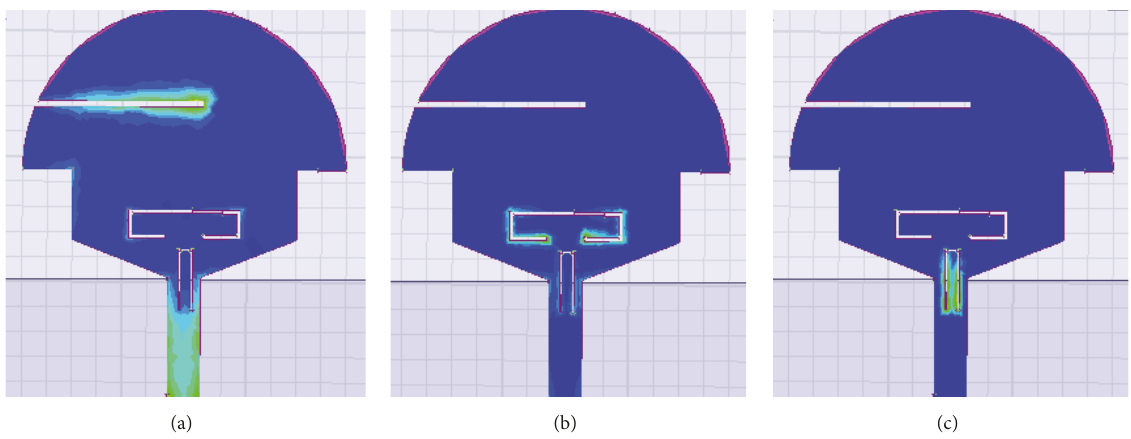
Figure 10: Surface current density of the UWB antenna (a) 3.5 GHz, (b) 5.4 GHz, and (c) 8.2